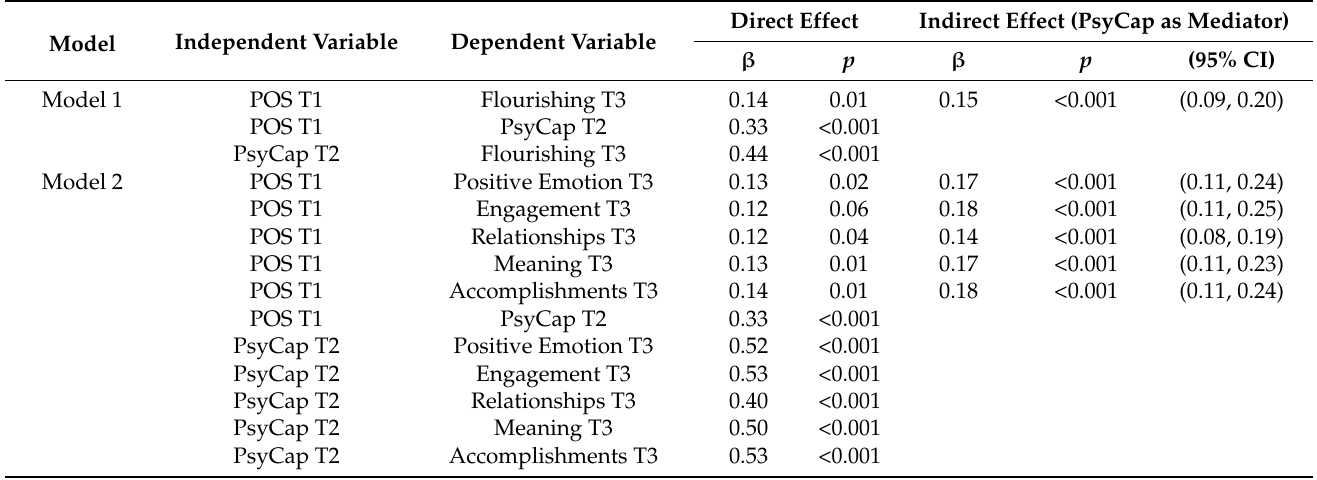
Table 3. Prospective Mediation Analysis from Perceived Organizational Support to Psychological Capital to Flourishing and PERMA.